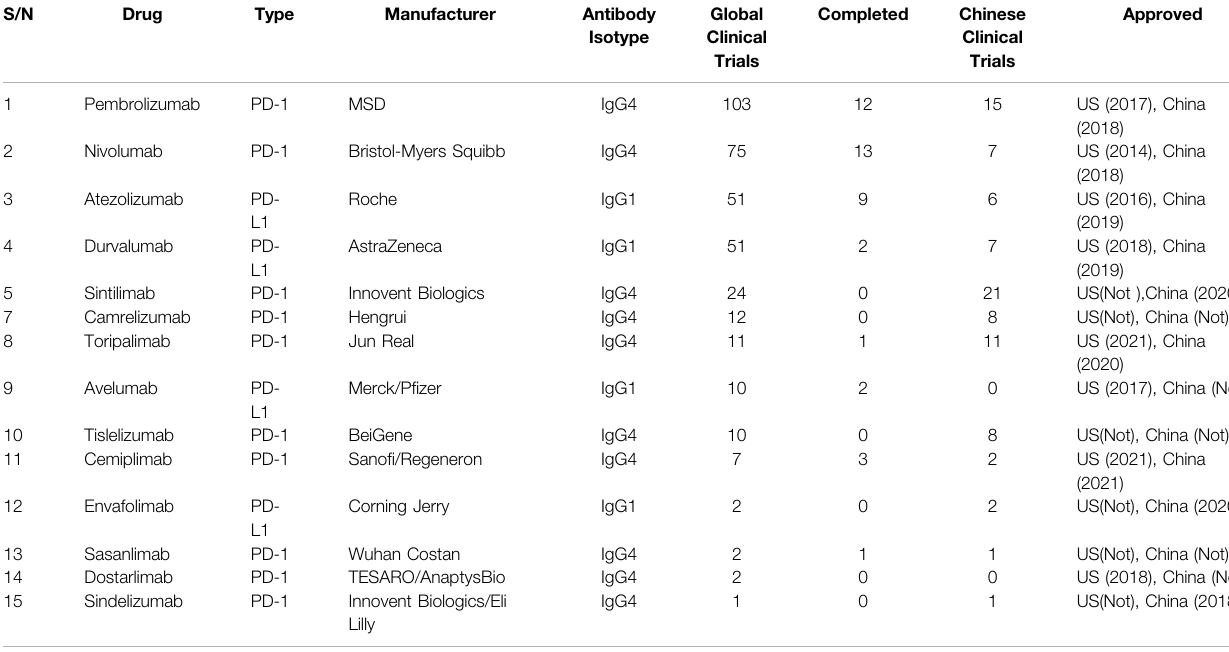
TABLE 1 | Summary of clinical trials of PD-1/PD-L1 immunosuppressants for NSCLC registered in clinicaltrials.gov. S/N Drug